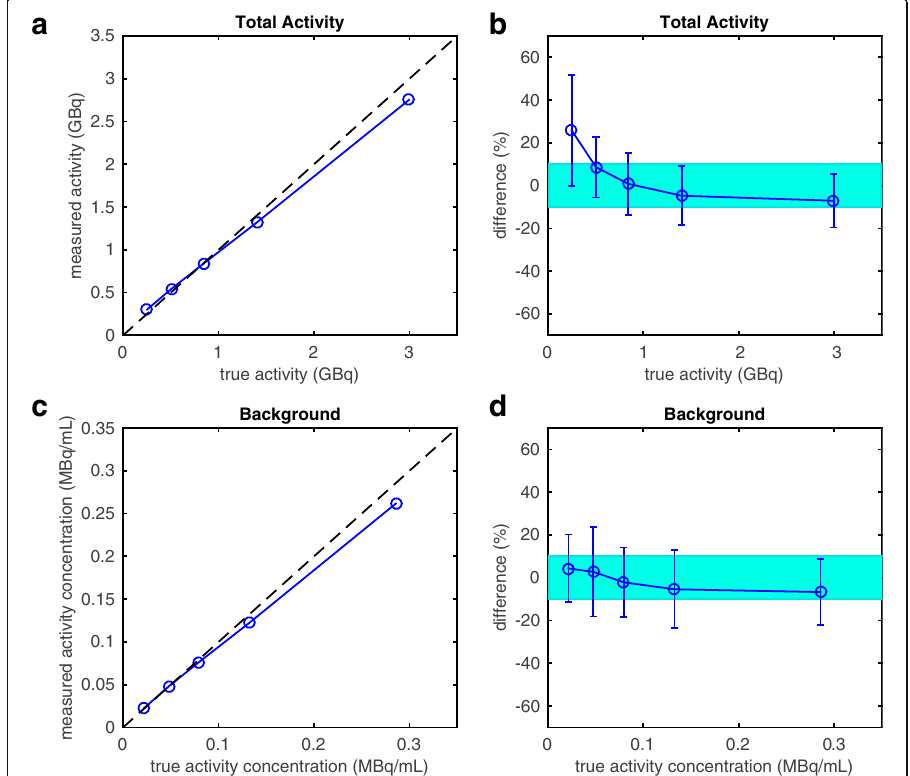
Fig. 3 a Total measured activity within the FOV compared to the true activity, averaged across the eight sites. The dashed line represents the identity (i.e., where measured equals true). b Error in measured activity within the FOV. Each point represents the mean measured activity across the eight sites. Error bars represent one standard deviation across the eight sites ’ measurements. The shaded region represents ± 10% error. c Mean activity concentration of the 37 mm VOI within the warm background compartment of the phantom compared to the true activity concentration, averaged across the eight sites. The dashed line represents the identity (i.e., where measured equals true). d Deviation of measured activity concentration within warm background. Each point represents the mean measured activity concentration of the 37 mm VOI across the eight sites. Error bars represent one standard deviation across the eight sites ’ measurements. The shaded region represents ± 10%